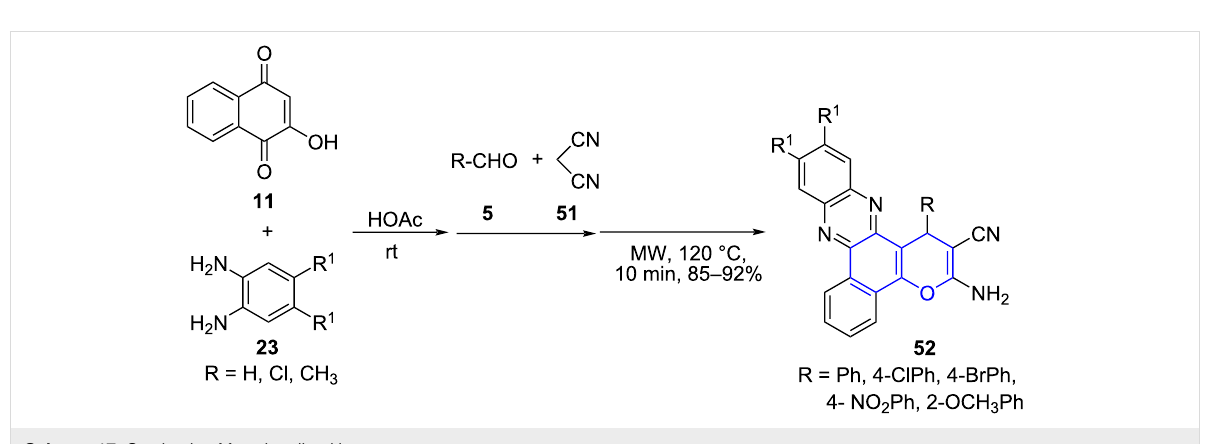
Figure 4: Pyran-containing biologically active molecules.